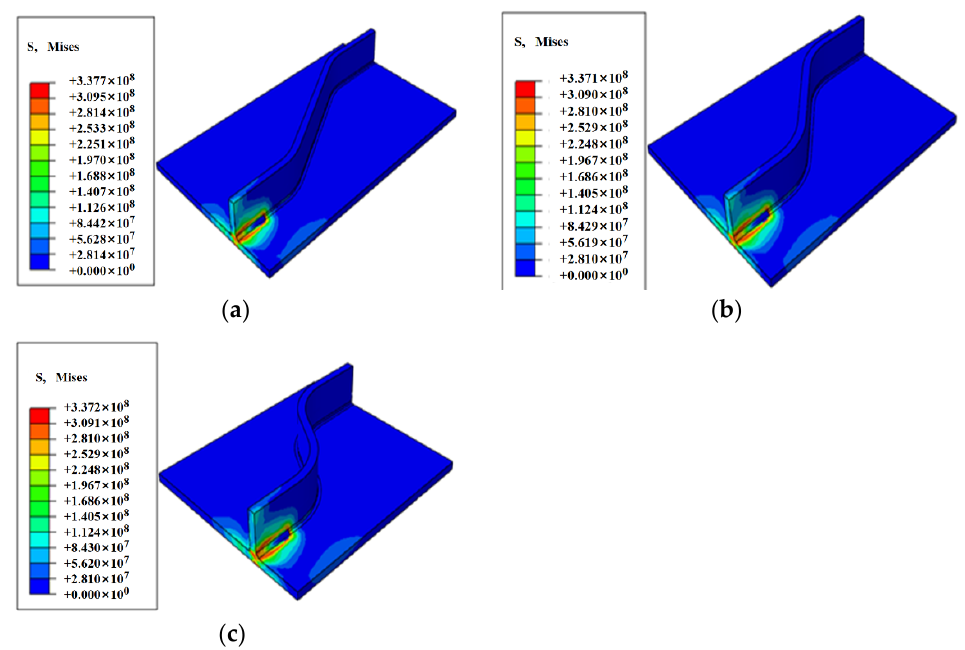
Figure 15. Stress field contour plot in welding stage (Unit: Pa); ( a ) Stress field at 20 s (30°); ( b ) Stress field at 20 s (45°); ( c ) Stress field at 20 s (60°).